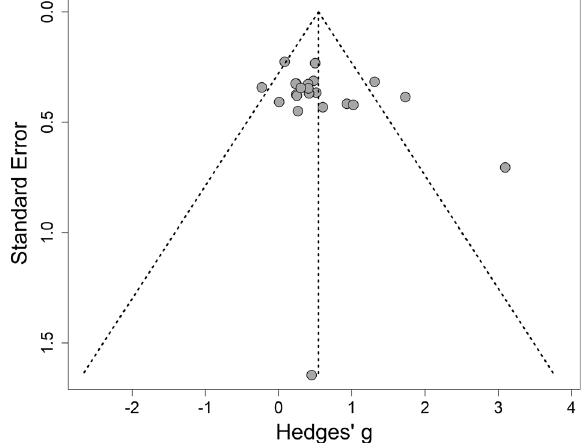
Fig. 2 Funnel plot of the publication bias. Studies with a smaller sample size are expected to have higher standard error, and are therefore expected to be located at the lower end of the y -axis, while the studies with more participants are expected to show a lower standard error, and thus be at the upper end of the y -axis. SE = Standard error, Hedges ’ g = The Hedges ’ bias-corrected standar- dized mean difference which was used to calculate the effect